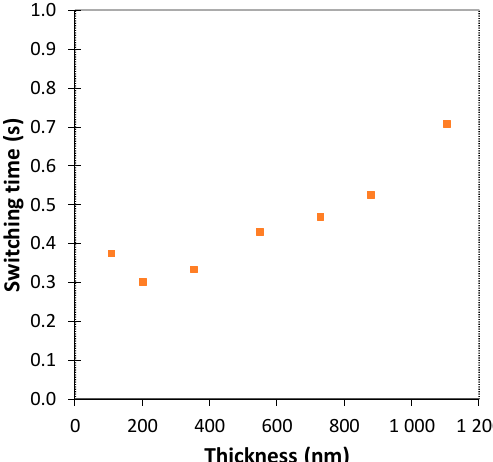
Figure A1. Current switching time as a function of PEDOT:PSS thickness in Figure A1 . Current switching time as a function of PEDOT:PSS thickness in displays.